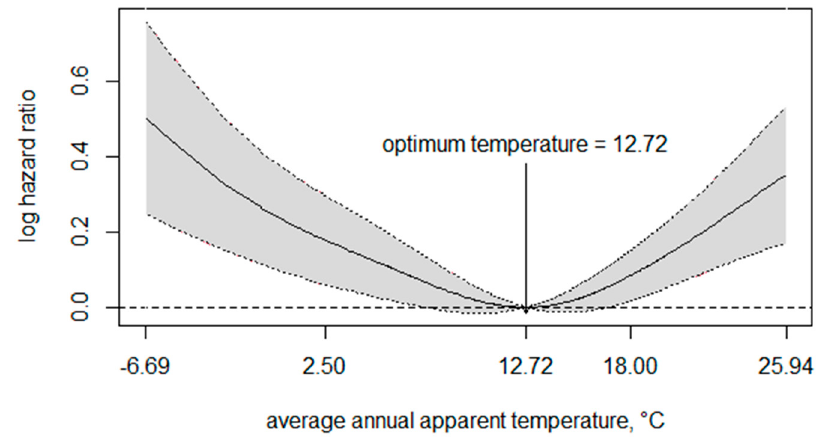
Figure 2. The exposure − response curve of long-term temperature exposure and depressive symp-